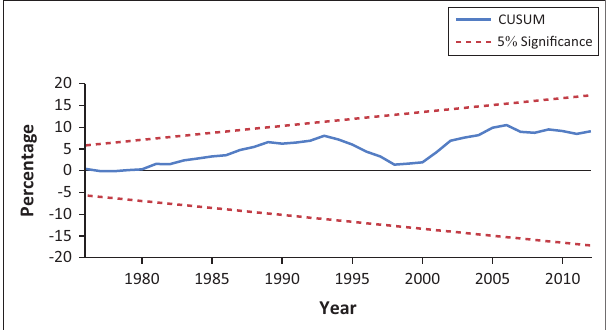
FIGURE 1: Cumulative sum test,